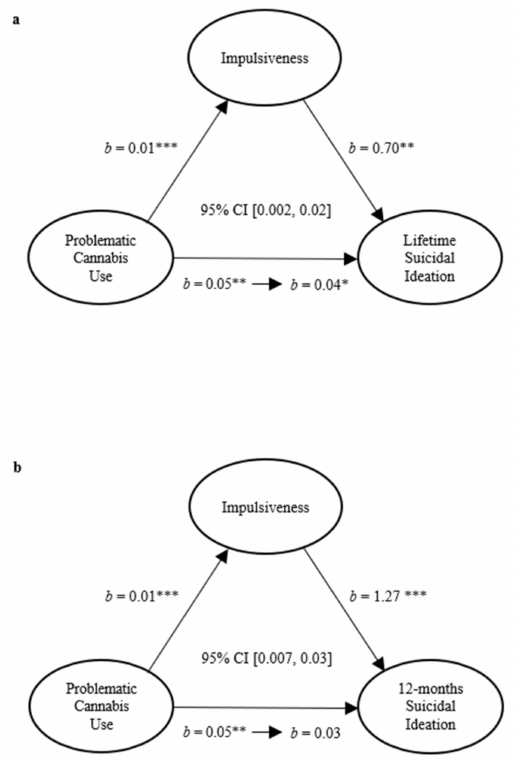
Figure 1. The mediating role of impulsiveness in the relationship between cannabis use and lifetime suicidal ideation ( a ) and past-12-months suicidal ideation ( b ). *** p < 0.001, ** p < 0.01, * p <